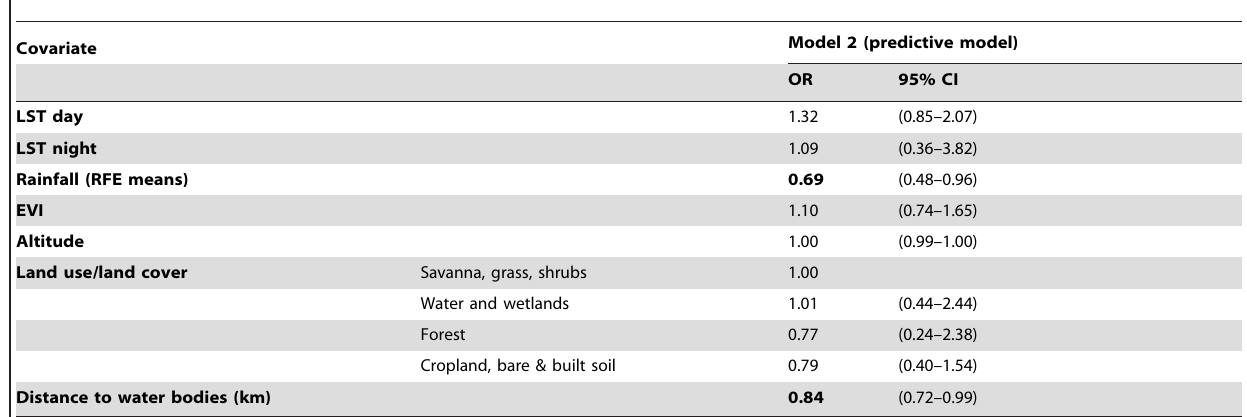
Table 4. Odds ratio and significance of environmental covariates in the predictive model (Model 2).